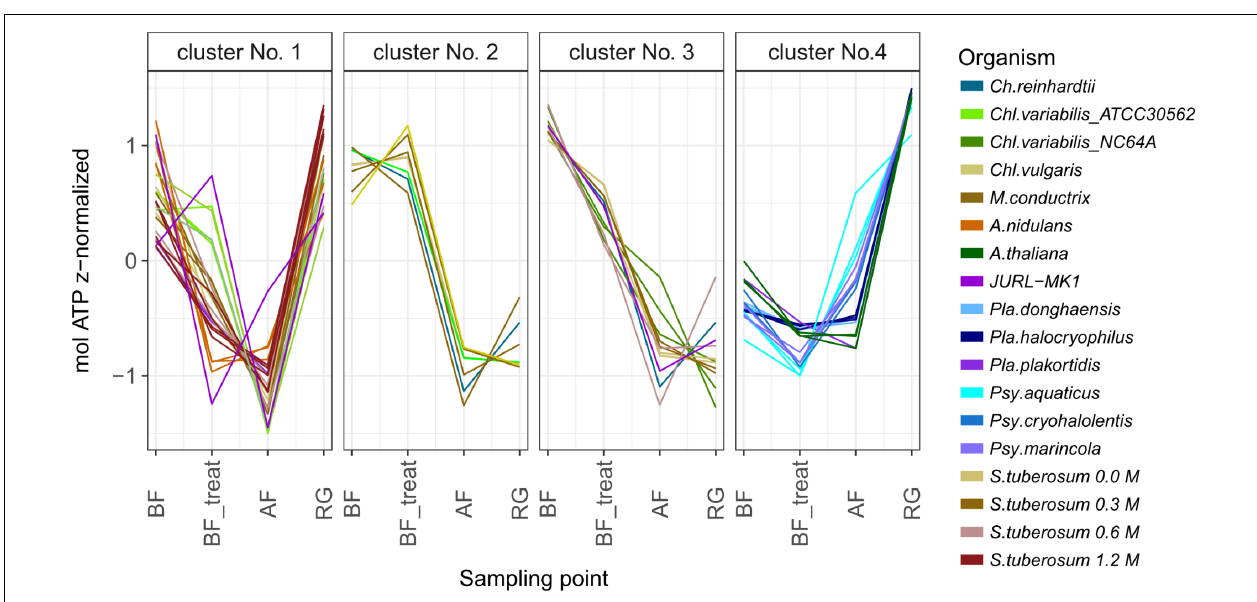
FIGURE 3 | Patterns of changes in intracellular ATP content observed for different organisms during cryostress. The pattern of ATP content observed under cryrostress for each strain or organism was fitted to different shapes employing the R package dtwclust. This analysis resulted in clusters of strains or organisms that could be assigned to four different shapes (Supplementary Figure S2). BF, before freezing; BF_treat, after treatment with cryoprotectant; AF, after freezing; RG, after the regrowth phase. Pla. , Planococcus ; Psy. , Psychrobacter ; Ch. , Chlamydomonas ; Chl. , Chlorella ; Mic., Micractinium; A. nidulans, Aspergillus nidulans; A. thaliana, Arabidopsis thaliana Col-0 shoot tips; S. tuberosum, Solanum tuberosum cv. Desiree suspension cells after pretreatment with different sorbitol concentrations.